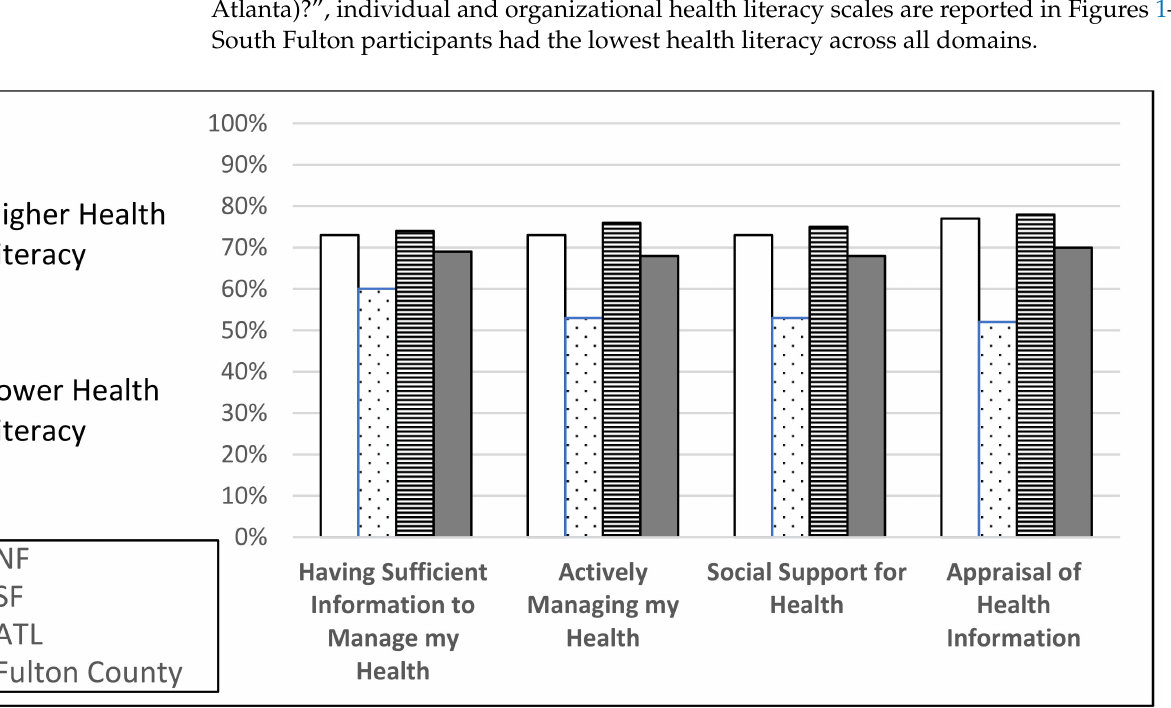
Figure 1. Individual Health Literacy Scale (cut point 50%) by County Area: Sufficient Informa- tion, Managing Health, Social Support, Appraisal of Information. Based on Level of Agreement (lower = strongly disagree/disagree; higher = agree/strongly